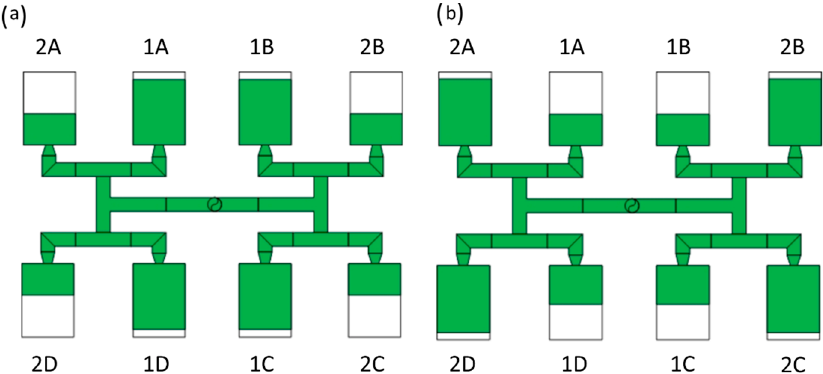
Figure 8. The concept of mass filling imbalance coefficient: ( a ) positive imbalance, I m > 0 (m 1 > m 2 ) ,